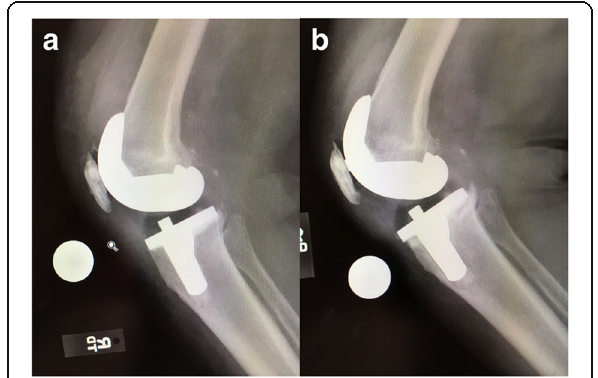
Fig. 1 The classic loosening of the implant in worst instances begins with a delamination pull-away of the cement on the posterior keel, followed by failure of the proximal posterior tibial surfaces; Compare the positioning immediately post-op ( a ) verses that at 6 months, where the slope changes from 7 o to 9 o and the implant subsides ( b )